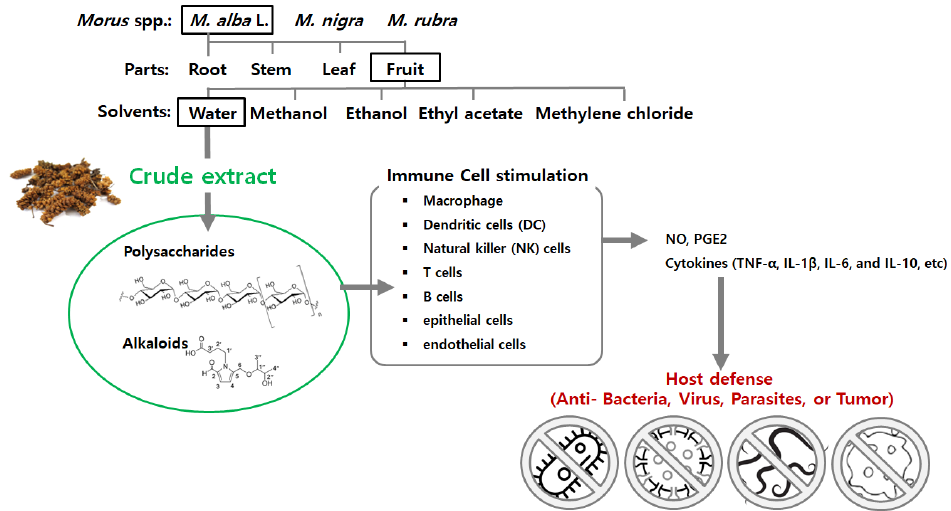
Figure 4. Summary of methods to improve immunological activity of Morus alba L.